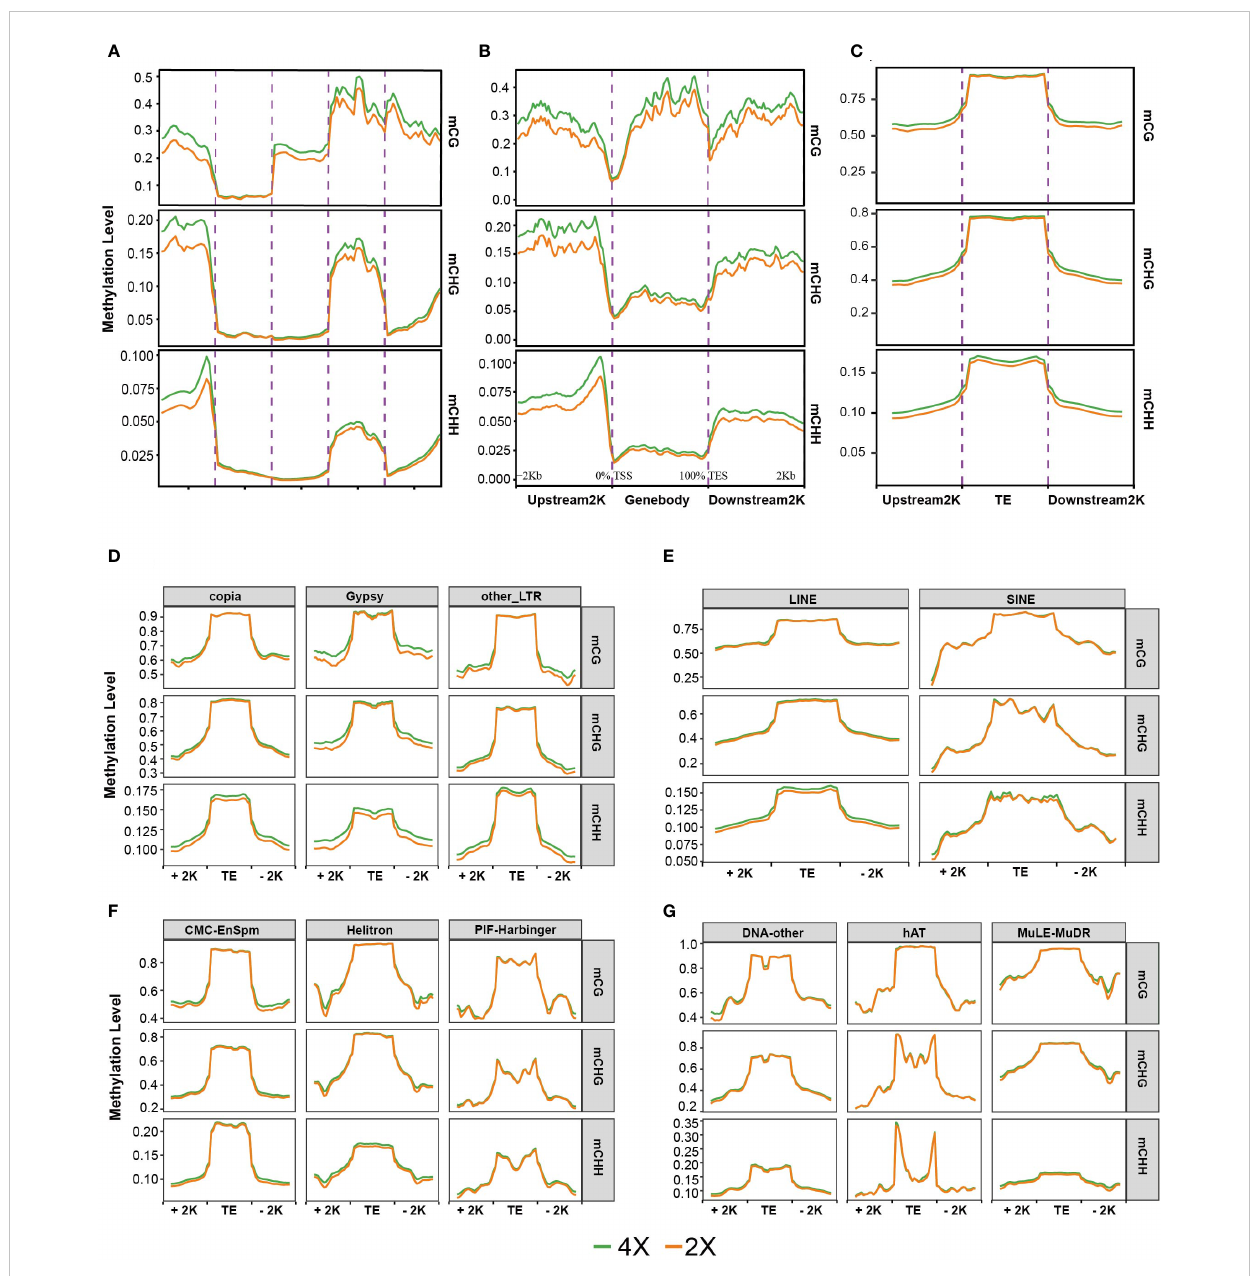
FIGURE 6 DNA methylation pro fi les. (A) Average methylation level in different regions of the genome. (B) Average methylation level distribution over gene body and fl anking region. (C) Average methylation level distribution over TE and fl anking region. (D, E) Average methylation level distribution over class I TEs. (F, G) Average methylation level distribution over class II